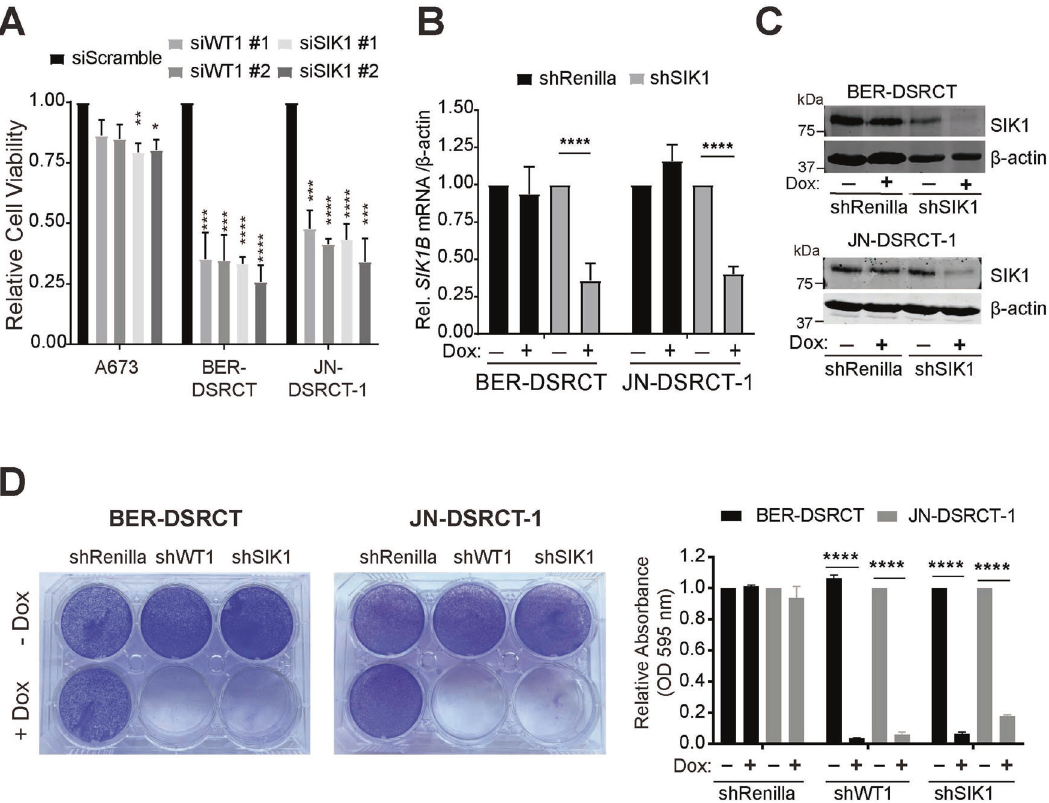
SEM, student t -test). B Relative mRNA expression of SIK1 after 3 days of doxycycline treatment (**** p < 0.0001, mean ± SEM, student t -test). C Western blot analyses showing SIK1 is effec t ively reduced in Dox-treated shSIK1 JN and BER-DSRCT cells compared to untreated or control cells. D Colony formation assay of dox-inducible shRenilla, shWT1, or shSIK1 DSRCT cell lines after 14 days of dox treatment (**** p < 0.0001, mean ± SEM, student t -test). The right panel shows quanti fi cation of the stained cells in the colony formation